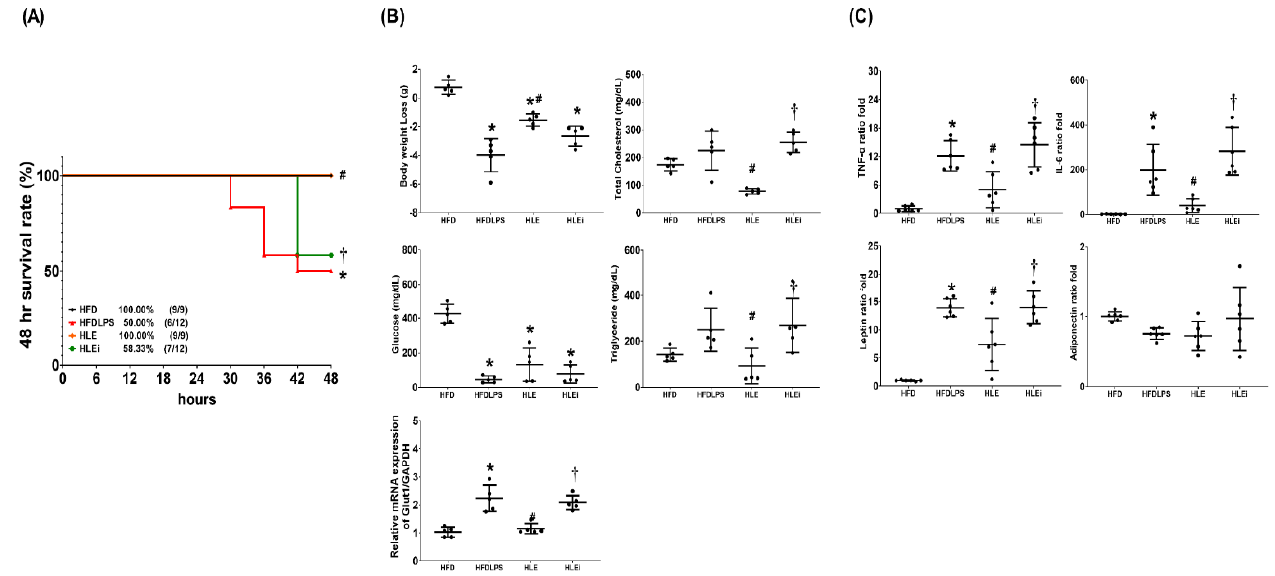
Figure 2. ( A ) The 48-h survival rates, as determined by calculating the number of mice in each group that survived the 48-h observational duration after endotoxin or normal saline (NS) administration. For this assay, 9, 12, 9, and 12 mice in each group were employed. ( B ) Body weight loss, concentrations of glucose, total cholesterol, and triglyceride in plasma, and the relative mRNA expression of glucose transporter 1 (GLUT1) in liver tissues (using a quantitative real-time polymerase chain reaction assay and normalized to the internal standard glyceraldehyde 3-phosphate dehydrogenase [GAPDH]), as measured at 48 h after endotoxin or NS administration in the surviving mice. Data were obtained from 5 mice in each group and presented as means ± standard deviations. ( C ) The ratio folds of tumor necrosis factor- α (TNF- α ), interleukin-6 (IL-6), leptin, and adiponectin concentrations in plasma, as measured at 48 h after endotoxin or NS administration in the surviving mice using an enzyme-linked immunosorbent assay. Data were obtained from 5 mice in each group, compared to those of HFD group, and presented as means ± standard deviations. HFD: the high-fat diet plus intraperitoneal (ip) administration of NS (0.5 mL) group. HFDLPS: the high-fat diet plus endotoxin (10 mg/kg, ip) group. HLE: the high-fat diet plus endotoxin plus exosomes (from human placenta choriodecidual membrane-derived mesenchymal stem cells, pcMSCs, 1 × 10 8 particles per mouse, ip) group. HLEi: the high-fat diet plus endotoxin plus microRNA-inhibitor-pretreated exosomes (1 × 10 8 particles per mouse, ip) group. * p < 0.05, versus the HFD group; # p < 0.05, the HLE group versus the HFDLPS group. † p < 0.05, the HLEi group versus the HLE